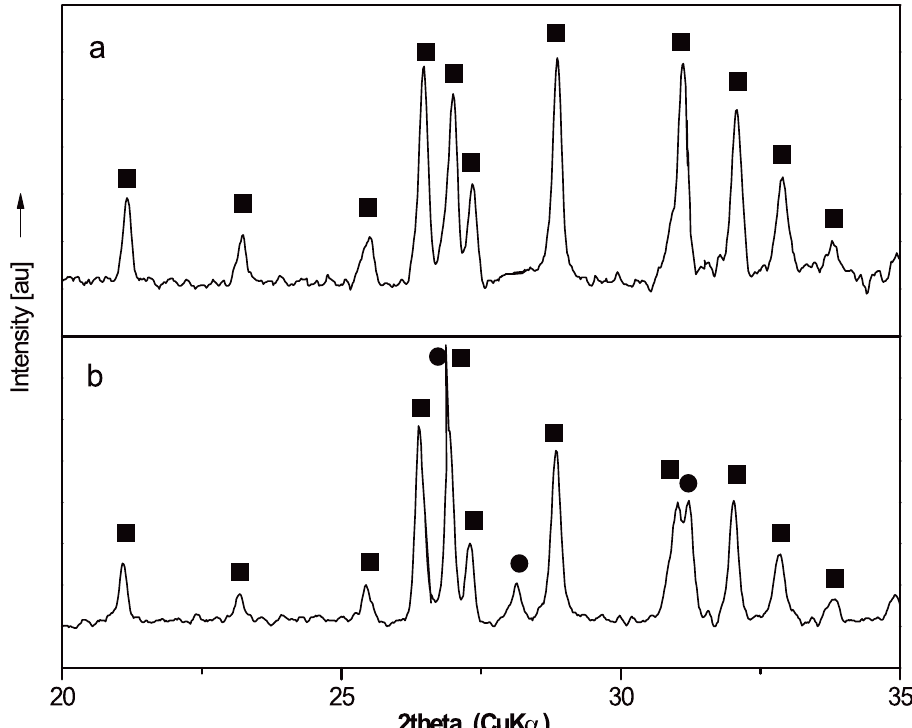
Figure 2. Powder diffraction patterns: a) PbBiVO ● - high-temperature PbBiVO